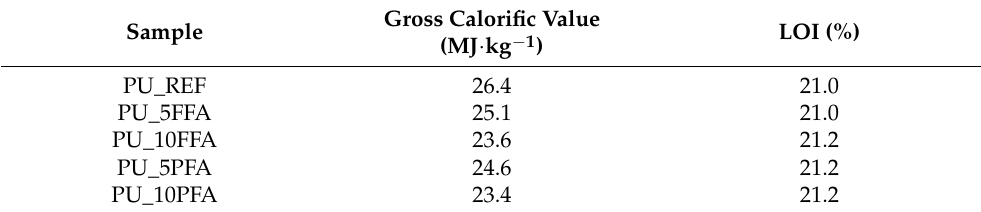
Table 4. Flammability properties of RPUFs.